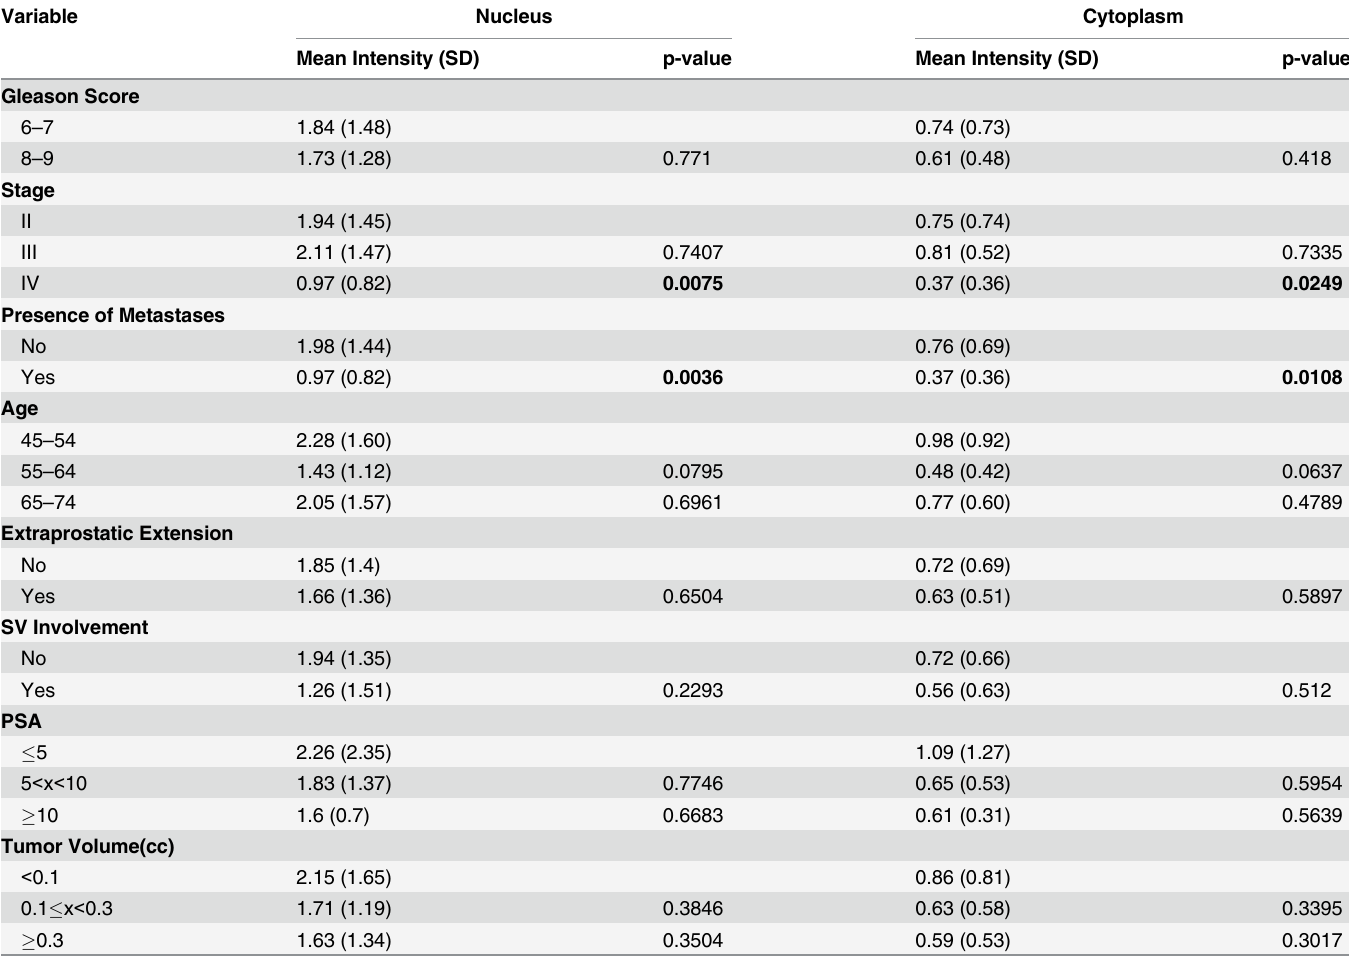
Table 2. Association of GLB1 with Clinicopathologic Characteristics in Primary PCa